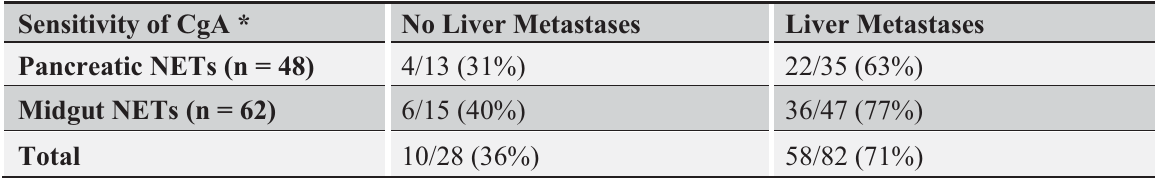
Table 3 . CgA sensitivities (number of patients with median CgA values above reference range/number of all patients of the corresponding group) depending on hepatic metastatic spread and tumor